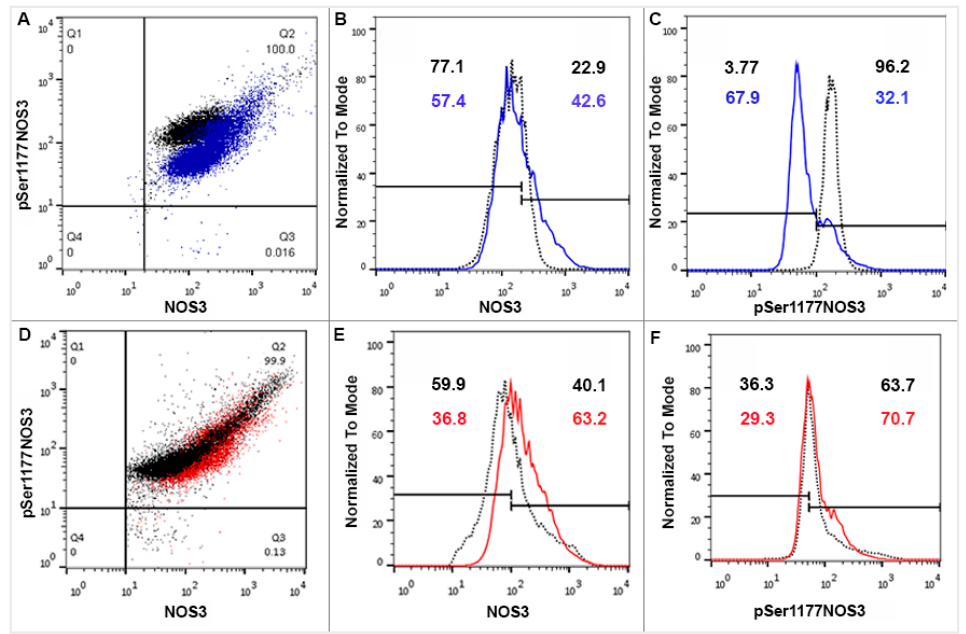
Figure 3. FACS (Fluorescence-activated cell sorting) analysis on arterial cord RBCs immunolabelled with NOS3 and pSer1177 NOS3 from the mature twin neonates and their matched singletons. Representative panels ( A , D ) show the dot plots of Hwt vs Hws and Lwt vs Lws RBCs, immunolabelled with anti-NOS3 and anti-pSer1177 NOS3 primary antibodies, respectively. The histograms ( B , E ) using FACS analysis show the NOS3 intensities in the Hwt (blue line) and Lwt (red line) with their matched singletons (black dots), similarly histograms ( C , F ) exhibit pSer1177 NOS3 intensities; in each case, according to the blank, an arbitrary borderline was considered dividing the total RBC population into basal and high